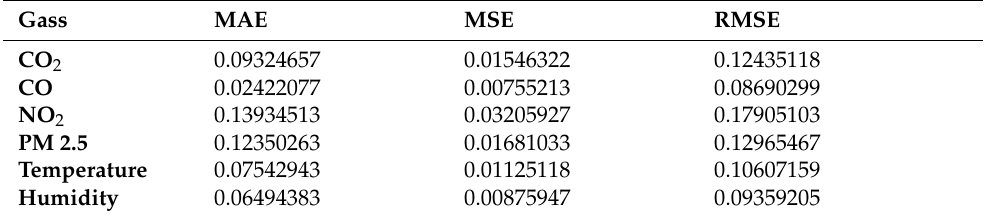
Table 3. Hourly Performance Evaluation of the LSTM.